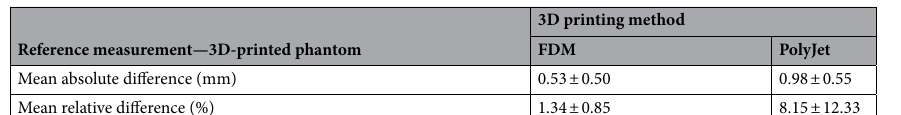
Reference measurement—3D-printed